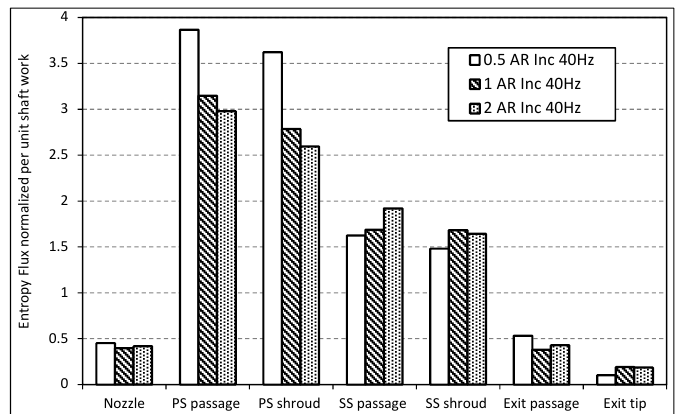
Figure 15. Entropy generation in rotor passage at minimum incidence.